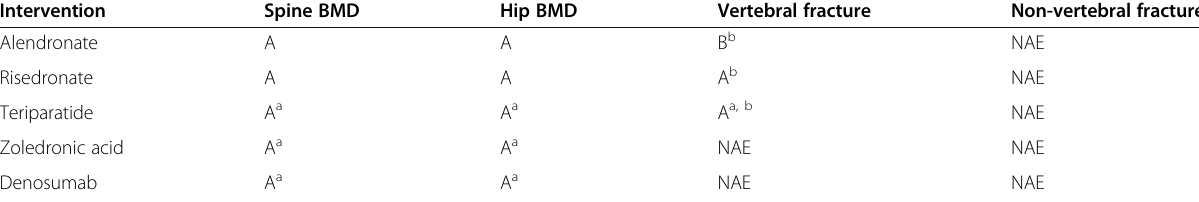
Table 4 Approved interventions for glucocorticoid-induced osteoporosis and its effect on BMD and fracture risk Intervention